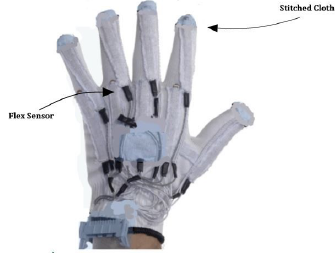
Figure 2. Placement of flex sensors in glove for hand gesture